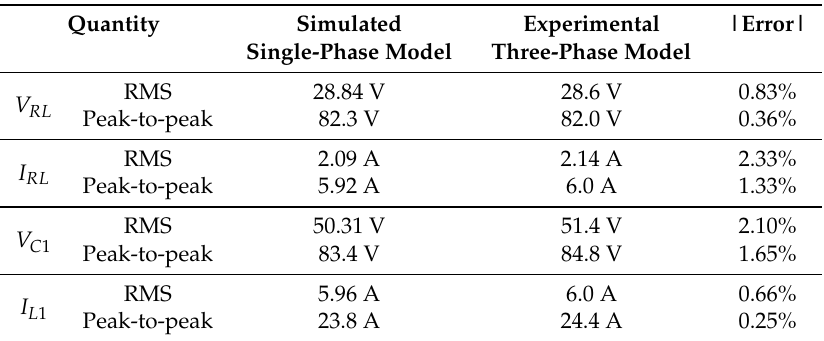
Figure 28. Load voltage and current for phase 1: RL load. Table 6. Comparison between simulated results of a single-phase model with experimental results of the three-phase model: RL load.